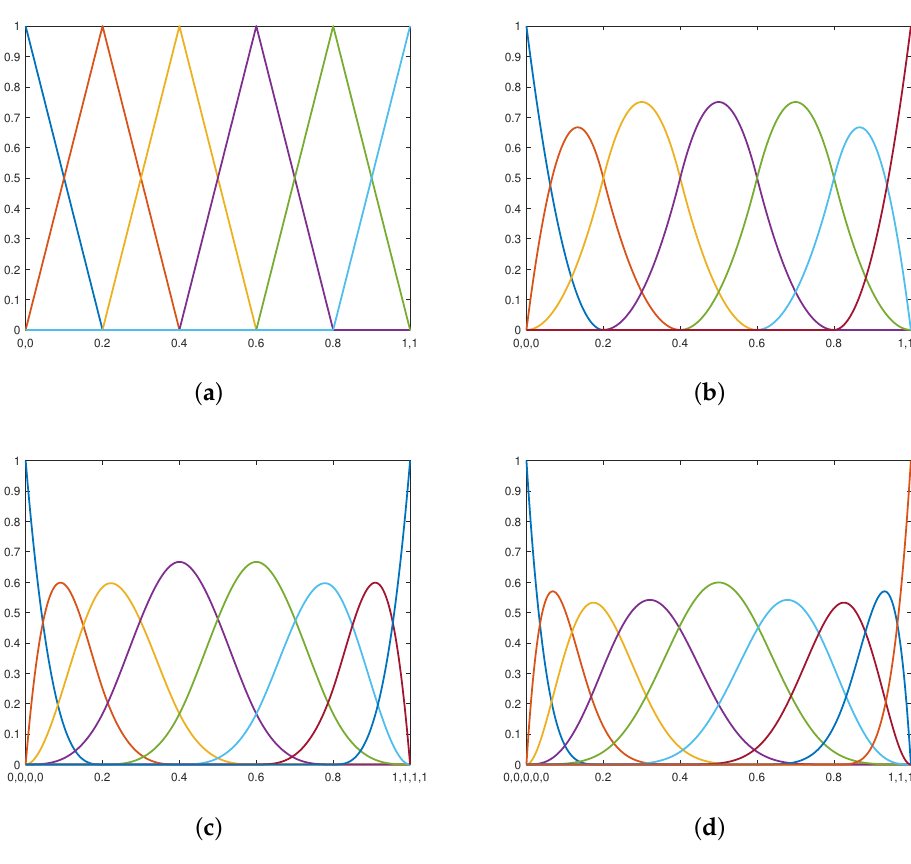
Figure 1. B-spline bases under different orders: ( a ) Linear. ( b ) Quadratic. ( c ) Cubic. ( d ) Quartic. For high-dimensional NURBS surfaces and solids, their blending basis functions are calculated by their tensor product